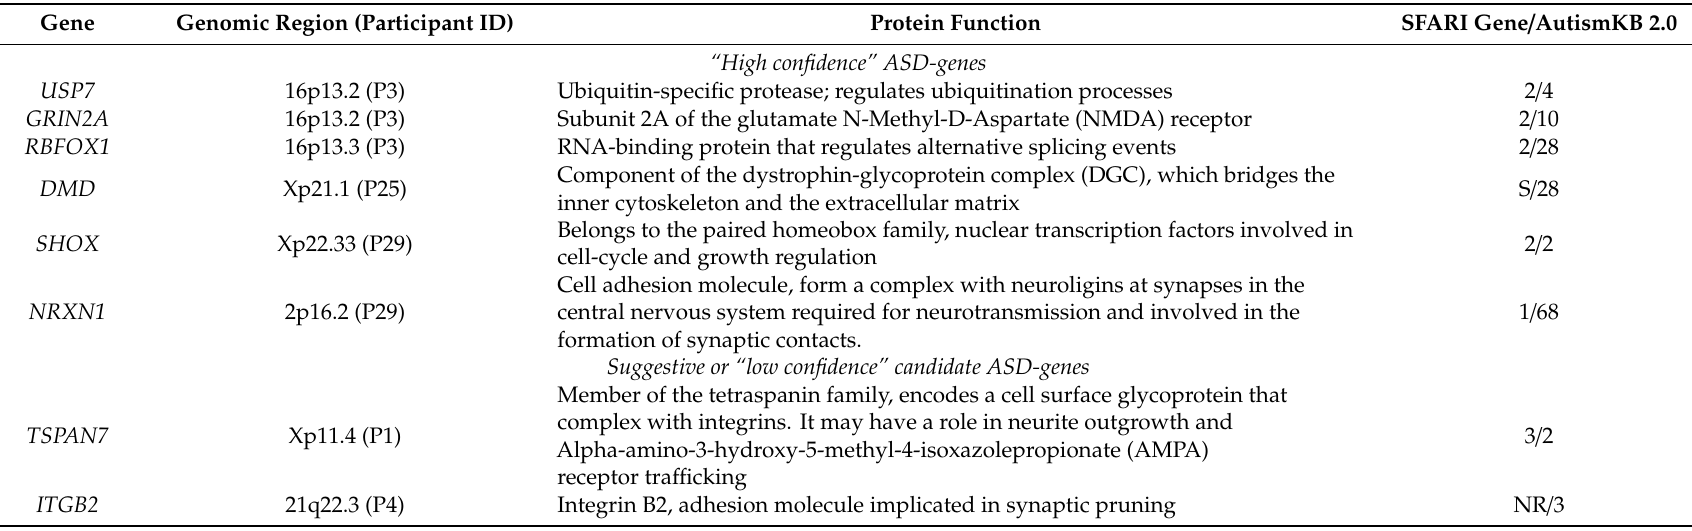
Table 2. Function and evidences of disease-association of the reported candidate-genes encompassed in causative- Copy Number Variants (CNVs). The table reports evidences that supports the possible role in autism of the reported “high confidence” autism spectrum disorder (ASD) genes (genes with a Simons Foundation Autism Research Initiative SFARI Gene score < 3 or with an Autism KB 2.0 score > 16), and suggestive or “low confidence” candidate-genes (genes with a SFARI Gene score ≥ 3 or with an AutismKB 2.0 score ≤ 16). For each gene, genomic region, participant ID, function of the encoded protein and scores assigned in the SFARI Gene and AutismKB 2.0 databases are reported (NR: gene not reported in the